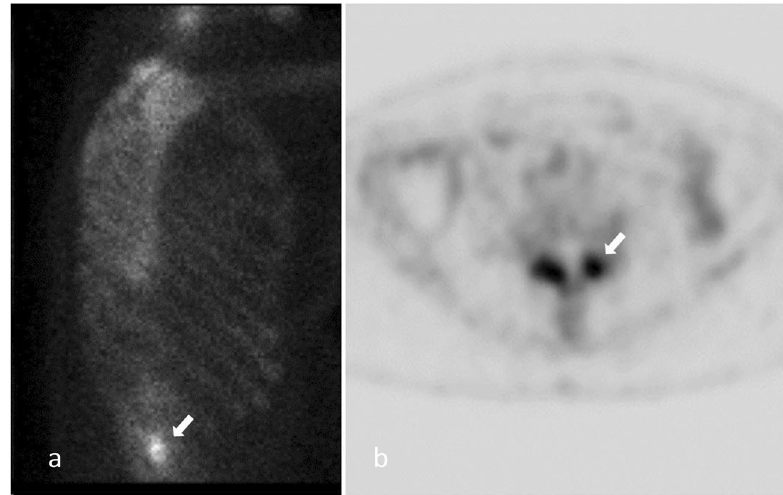
Fig. 7 SPECT imaging of FJ. Hyperfixation on bone scintigraphy located on FJ capsule inflammation (white arrow)